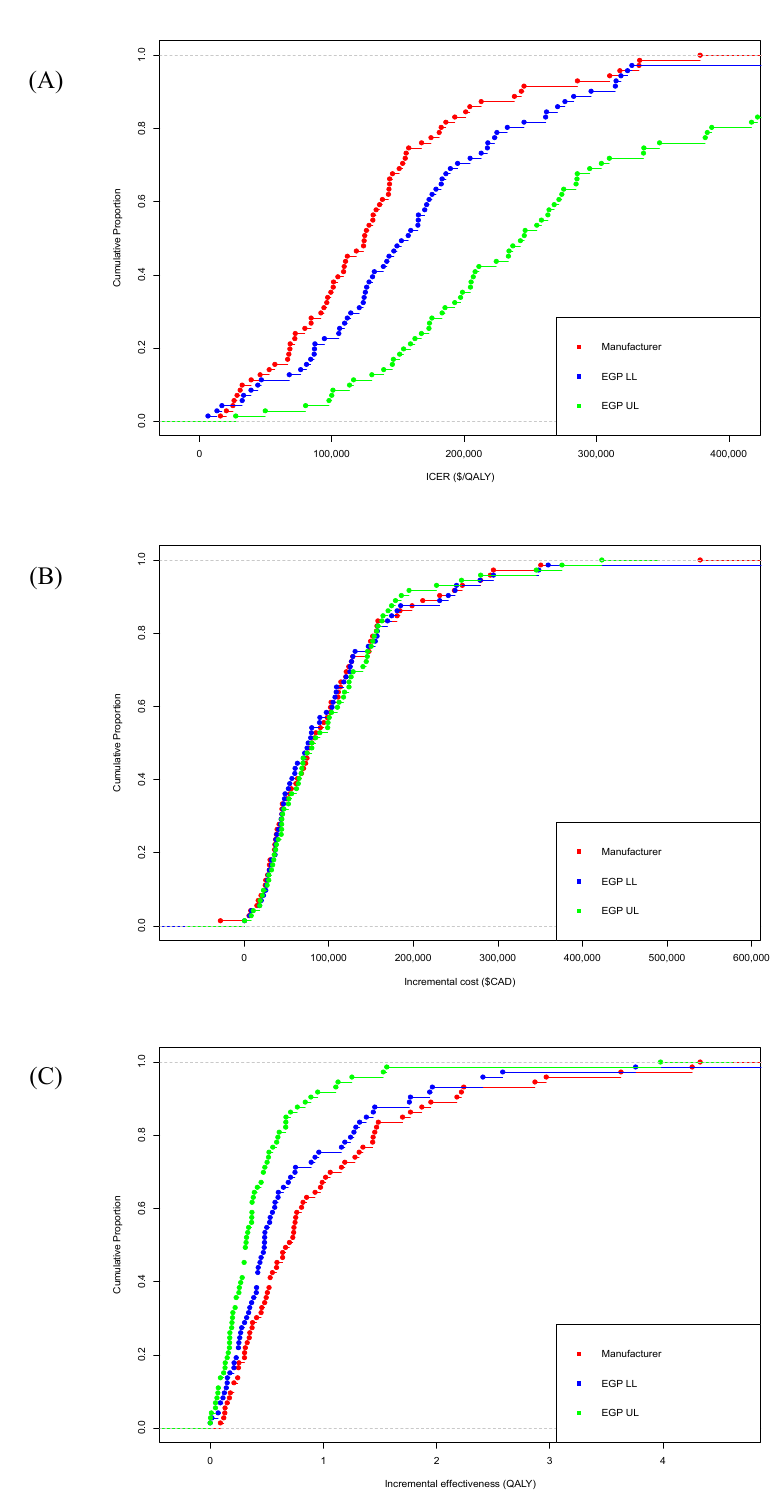
Figure 2. Cumulative distribution plots of manufacturer-submitted and economic guidance panel (EGP)-re-analyzed ( A ) incremental cost-e ff ectiveness ratios (ICERs), ( B ) incremental cost, and ( C ) incremental e ff ectiveness for each indication. EGP—economic guidance panel; LL—lower limit; UL—upper limit; ICER—incremental cost-e ff ectiveness ratio; QALY—quality-adjusted life